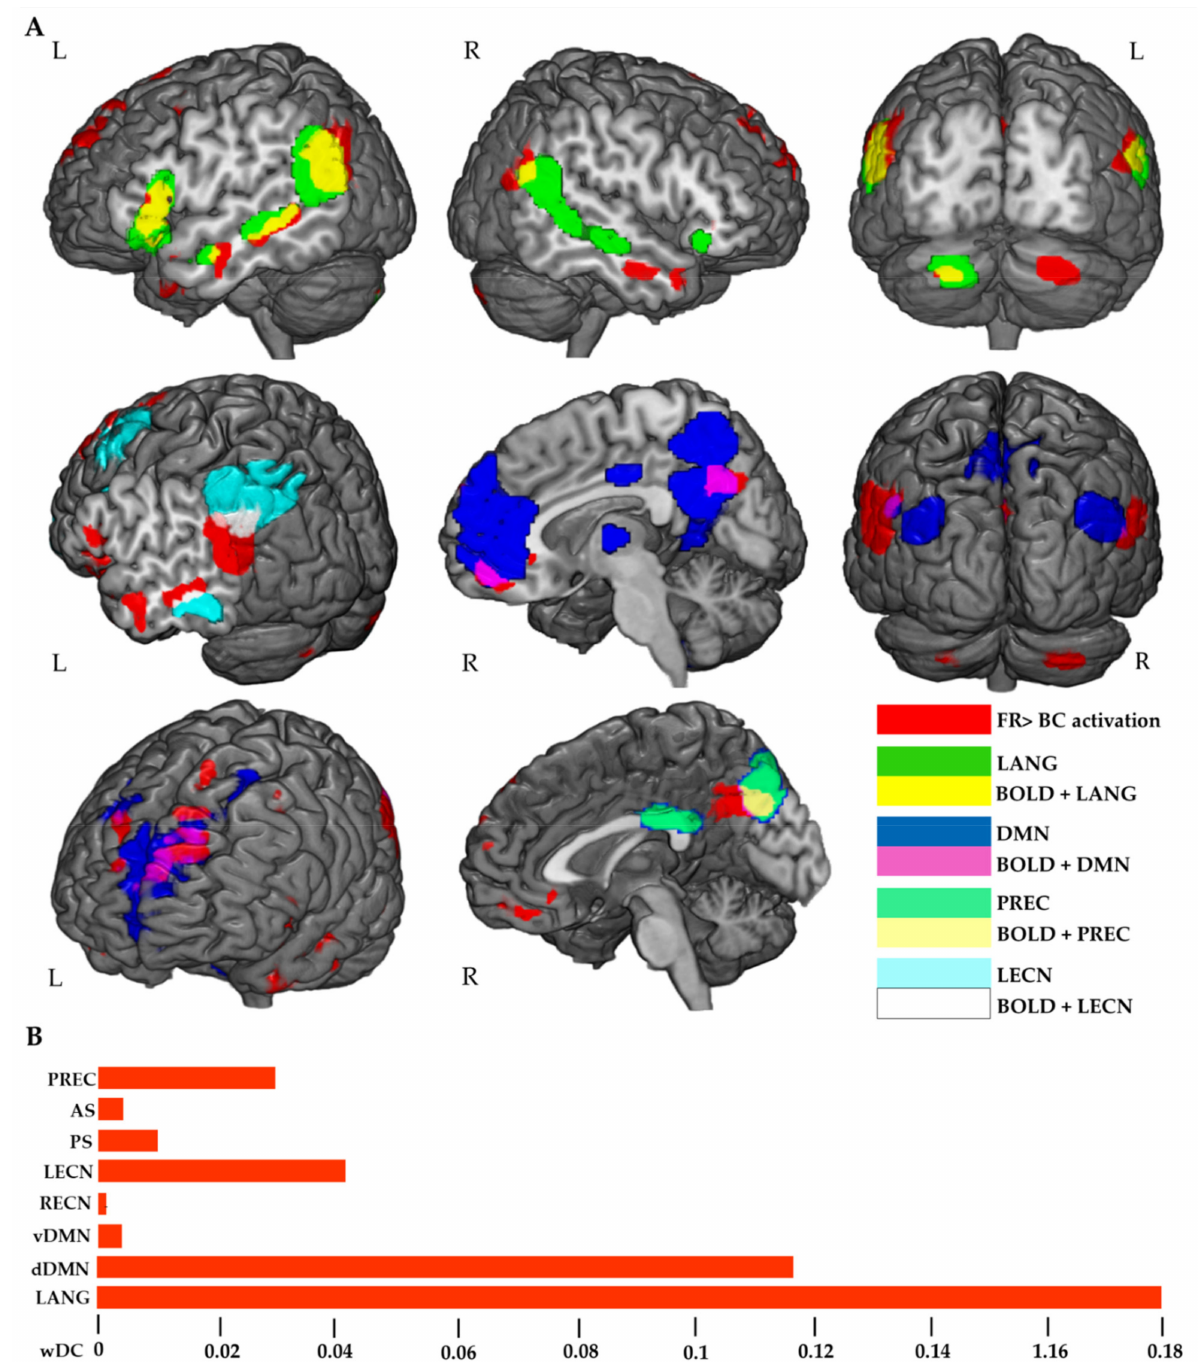
Figure 2. Overlap maps between FR > BC activation (RED) and RSNs. The image shows the greater similarity between activation and DMN/LANG RSNs ( A ). wDC results confirm a high similarity between FR > BC activation and dDMN, LANG, PREC and LECN networks ( B ). vDMN and dDMN: ventral and dorsal default mode network, respectively; RECN and LECN, right and left executive control networks, respectively; AS and PS, anterior and posterior salience networks, respectively; LANG, language network; PREC, precuneus